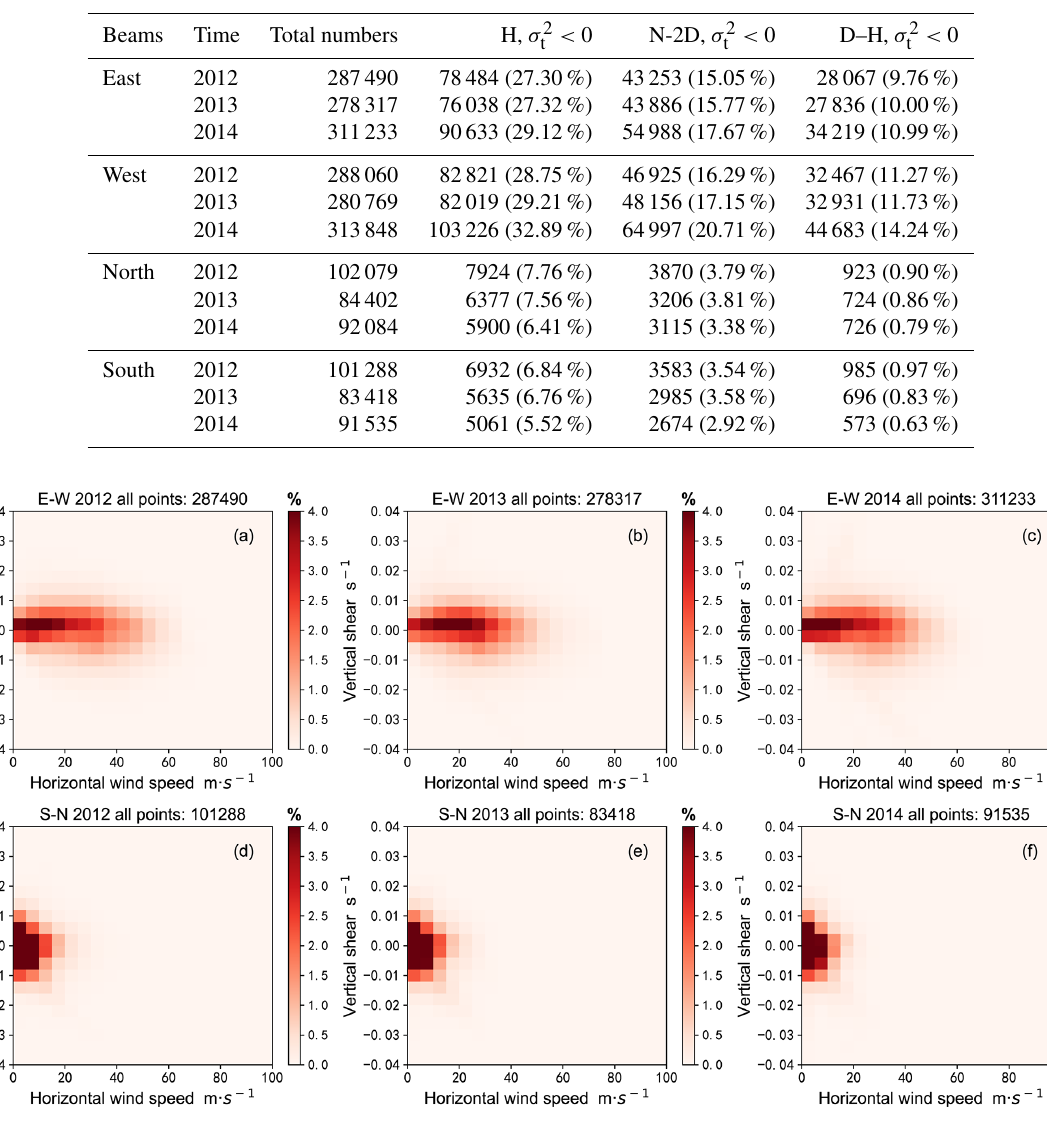
Table 2. Total frequency of σ 2 t < 0 in the range of 3–19.8km.